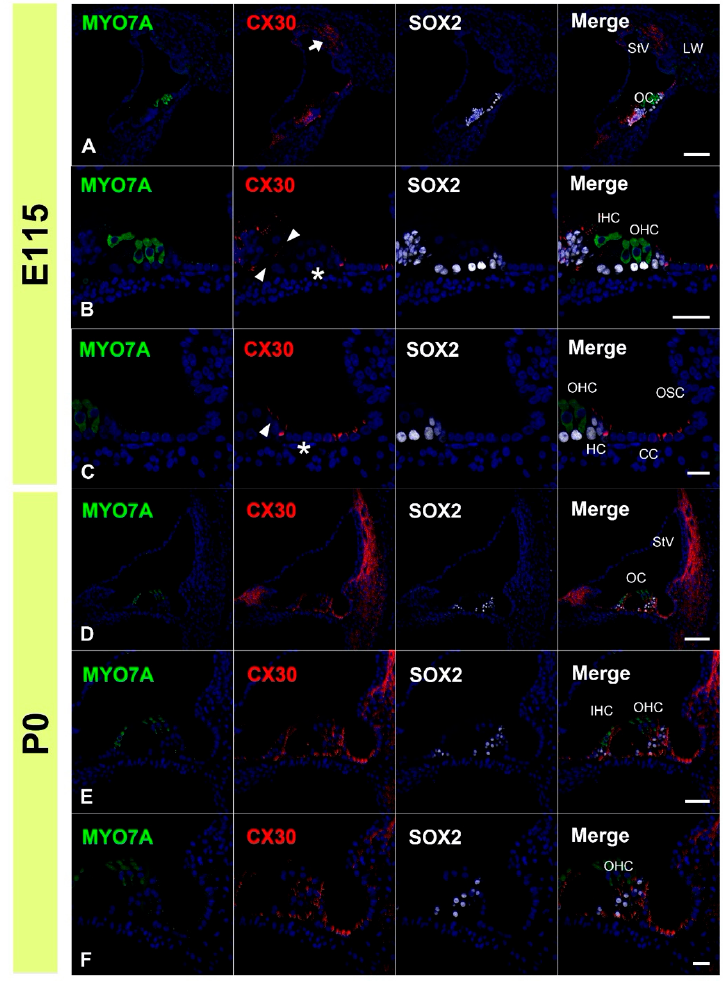
Figure 4. Changes in the expression patterns of CX30 at E115 and P0. ( A – C ) At E115, expression of CX30 was detected in a part of the sensory epithelium, but no expression was observed in the MYO7A-positive hair cells. Weak expression was observed in the spiral ligament fibrocytes next to the stria vascularis (arrow in ( A )). CX30 expression was also observed at the modiolus-side membrane of inner pillar cells (arrowheads in ( B )). At this stage, no CX30 expression was detected in Deiters’ cells (asterisk in ( B )). In Hensen’s cells, however, expression of CX30 was detected (arrowhead in ( C )). Notably, in Claudius’ cells, cells located on the modiolus side showed no expression of CX30 (asterisk in ( C )), while expression was detected in cells on the spiral ligament side. ( D – F ) At P0, strong CX30 expression was observed in spiral ligament fibrocytes and the organ of Corti (arrowhead in ( E )). SOX2 was used to label supporting cells. Nuclei were counterstained with Hoechst stain (blue). Scale bar: 100 µm in ( A , D ), 50 µm in B and E, 20 µm in ( C , F ). OC: organ of Corti, StV: stria vascularis, LW: lateral wall fibrocytes, IHC, inner hair cells; OHC, outer hair cells, CC: Claudius’ cells, HC: Hensen’s cells, OSC: outer sulcus cells. ( A – F ): basal turn.